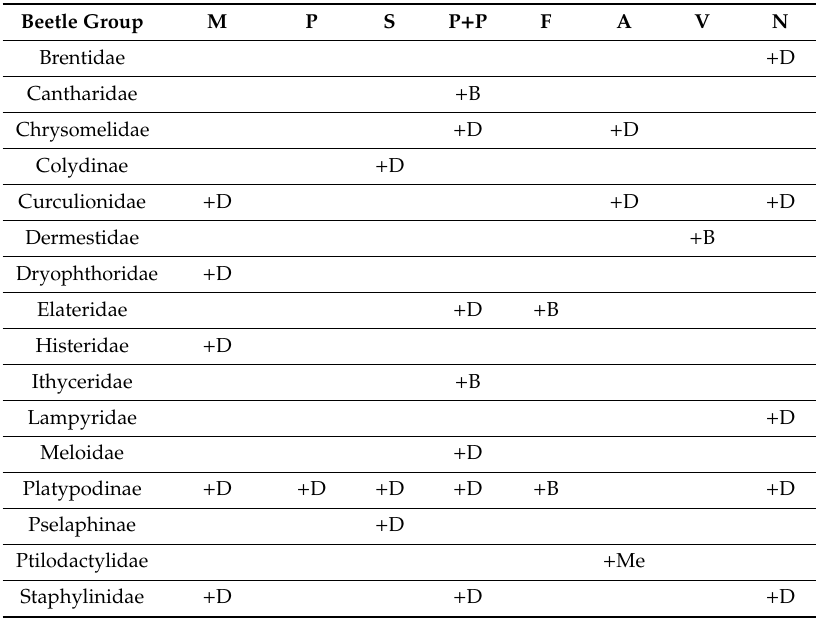
Table 1. Beetle groups with associated organisms included in the present work. Beetle Group